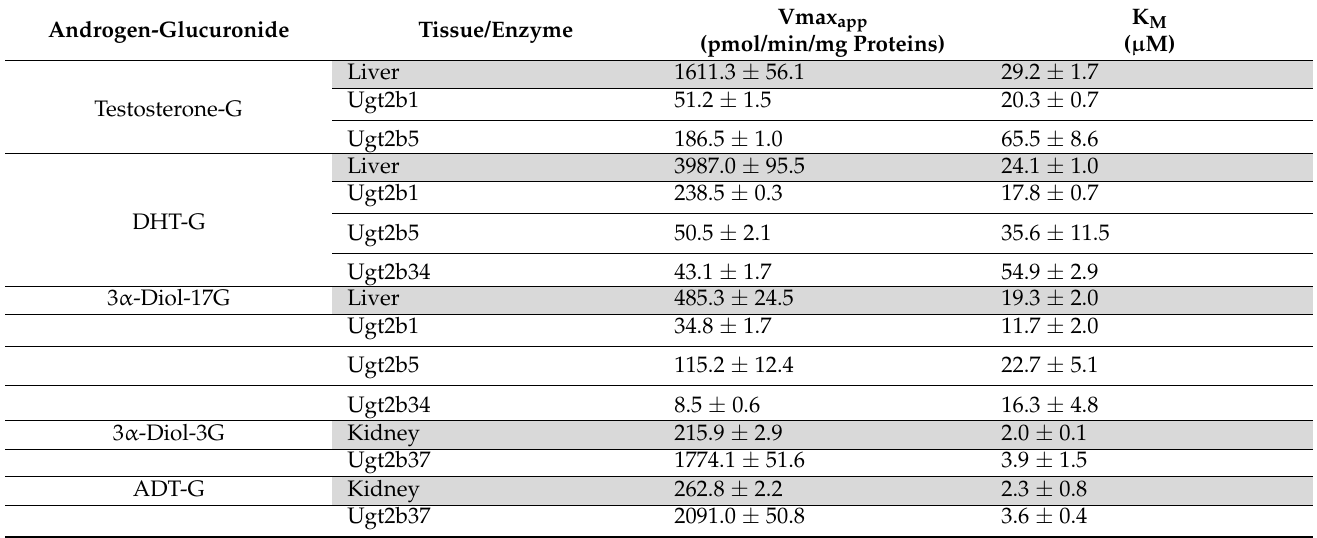
Table 3. Kinetic parameters of androgens glucuronidation by microsomal proteins from male liver, kidney, and recombinant Ugt2b